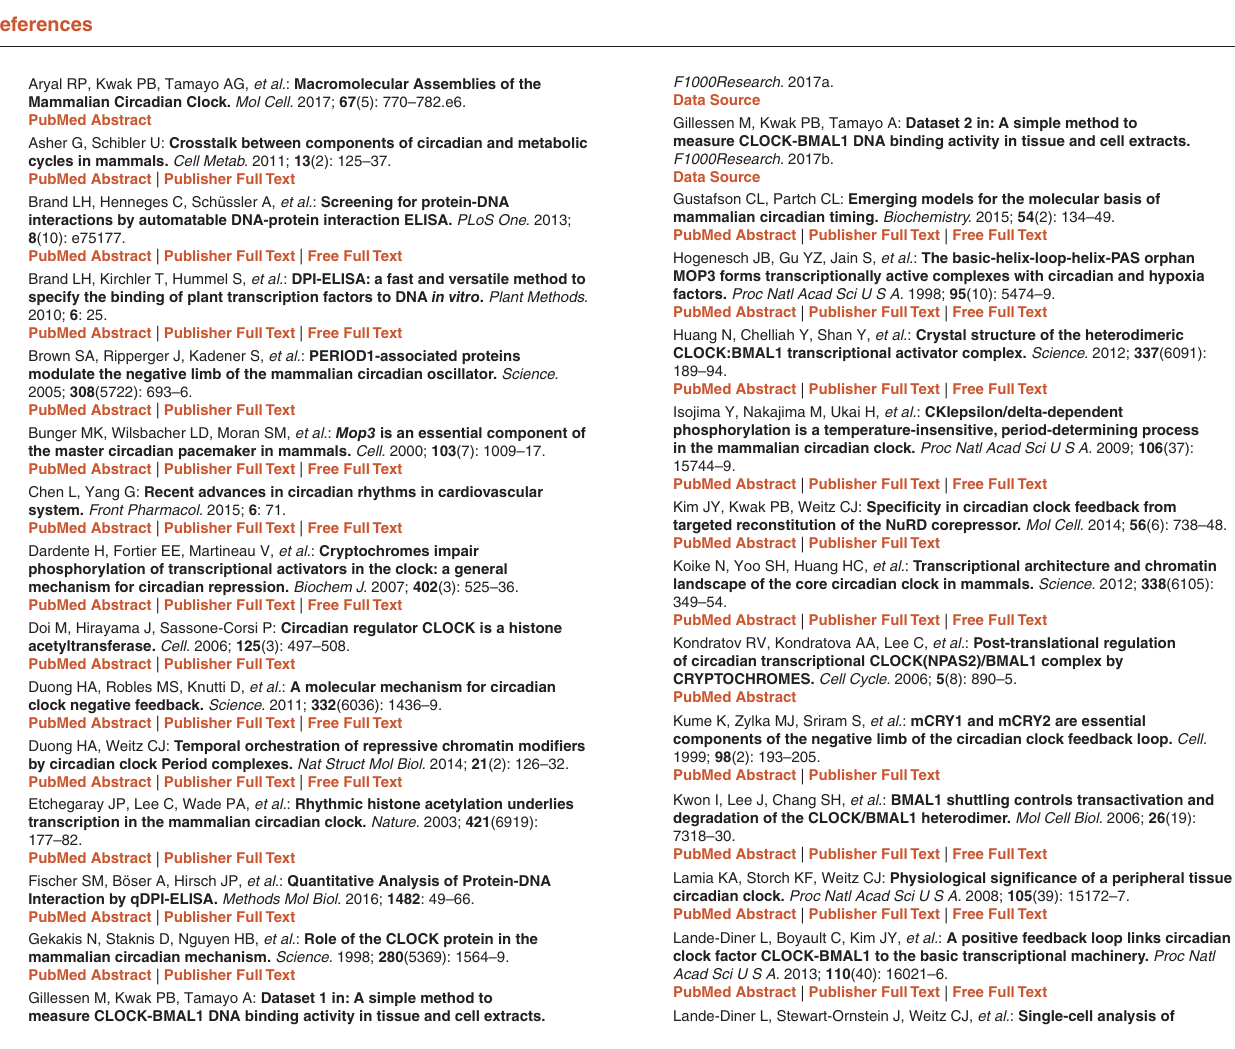
Figure S1. Native clock proteins bind specifically to immobilized E-box DNA sequences. Cytoplasmic (C) and nuclear (N) extracts were prepared from the livers of mice expressing PER2-FLAG-HA at CT16. ( A ) SDS-PAGE/immunoblotting was used to assess the presence of PER2, CLOCK, CRY1 and BMAL1 (equal loading by volume). Anti-FLAG (Sigma-Aldrich) or IgG negative control was used to co- immunoprecipitate clock proteins from C or N extracts. ( B ) Immobilized dsDNA containing E-box sequences (E-box DNA) or scrambled E-box sequences (Control DNA) were incubated with either C or N extracts. Bound proteins were eluted under denaturing conditions, then analyzed by SDS-PAGE/immuno-blotting for clock proteins. Click here to access the data. Figure S2. Segregation of nuclear and cytoplasmic markers from mouse liver extracts. Nuclear and cytoplasmic extracts were prepared from mouse livers harvested over circadian time. Extracts were analyzed by SDS-PAGE/immuno-blotting for the presence of RNA polymer- ase II (nuclear marker) and tubulin (cytoplasmic marker). Click here to access the